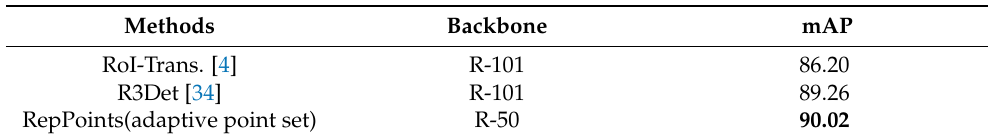
Table 6. Comparisons between anchor-based orientation regression methods and our adaptive-point- set-based method. The best result is bolded.